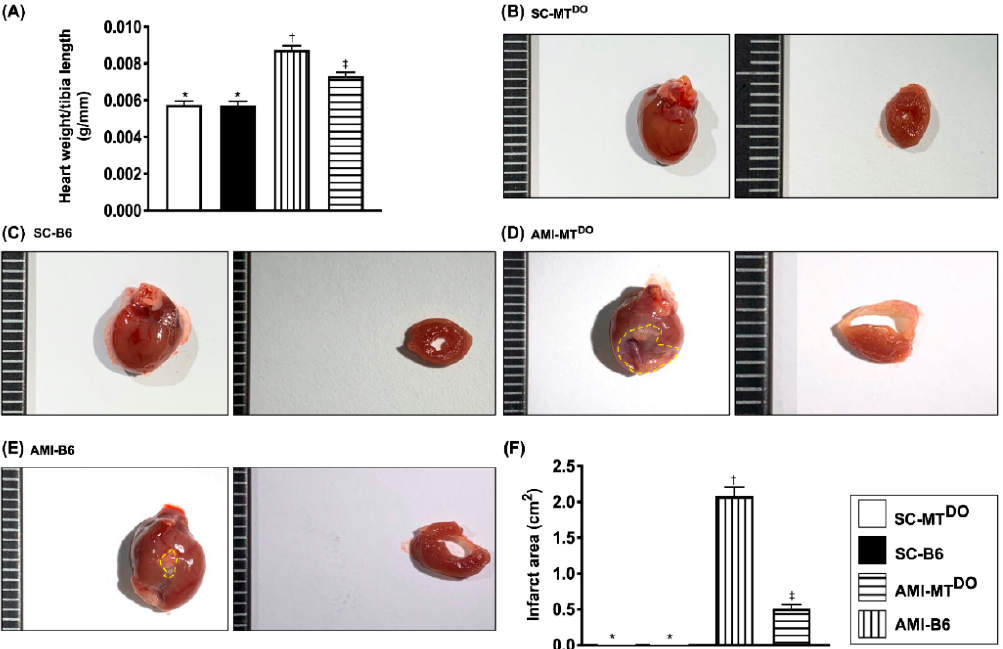
Figure 2. The heart and lung weight and gross anatomical infract area by day 60 after AMI procedure. ( A ) The ratio of heart weight to tibial length, * vs. other groups with di ff erent symbols ( † , ‡ ), p < 0.01. ( B–E ) Illustrating the morphological features (i.e., the total heart and the cross-section of the heart) of the heart and infarct zone (yellow dotted line) among the four groups. ( F ) Analytical result of gross anatomical infarct area, * vs. other groups with di ff erent symbols ( † , ‡ ), p < 0.0001. All statistical analyses were performed by one-way ANOVA, followed by Bonferroni multiple comparison post hoc test ( n = 10 for each group). Symbols (*, † , ‡ ) indicate significance (at 0.05 level). SC = sham-operated control; MT DO = double knock out of matrix metalloproteinase (MMP)-9 and tissue plasminogen (tPA) in mice; B6 (i.e., wild type) = C57BL / 6 mice. AMI = acute myocardial